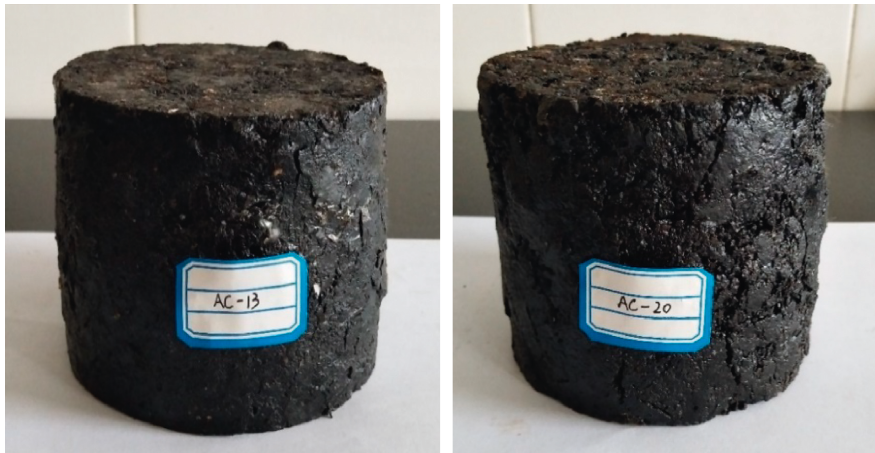
Figure 9: Failure specimens of triaxial test ((a) AC-13; (b) AC-20).